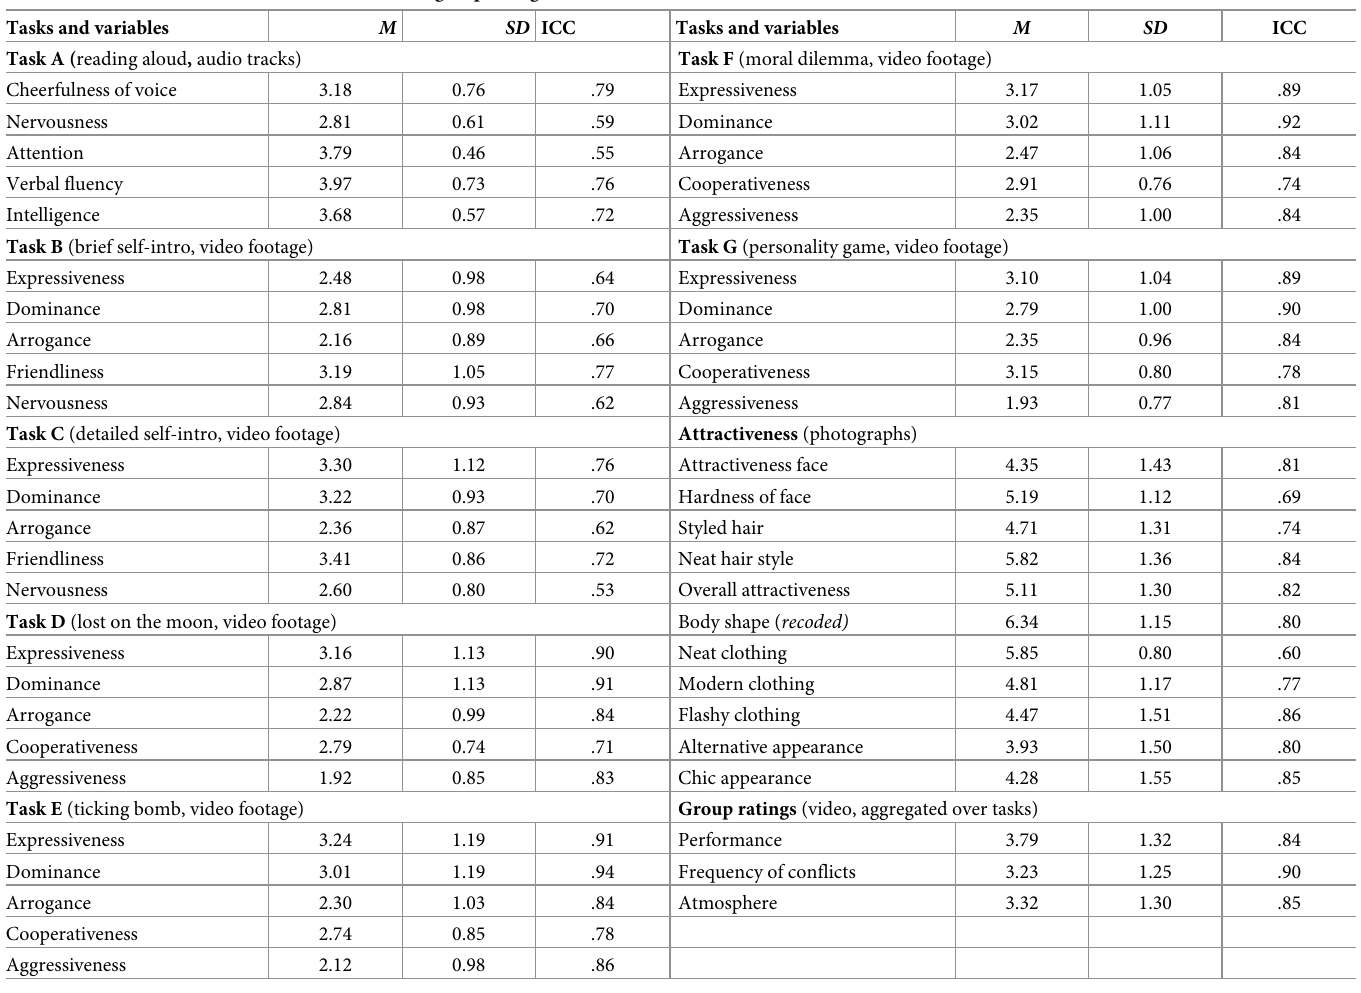
Table 8. PILS selected behavior, attractiveness, and group